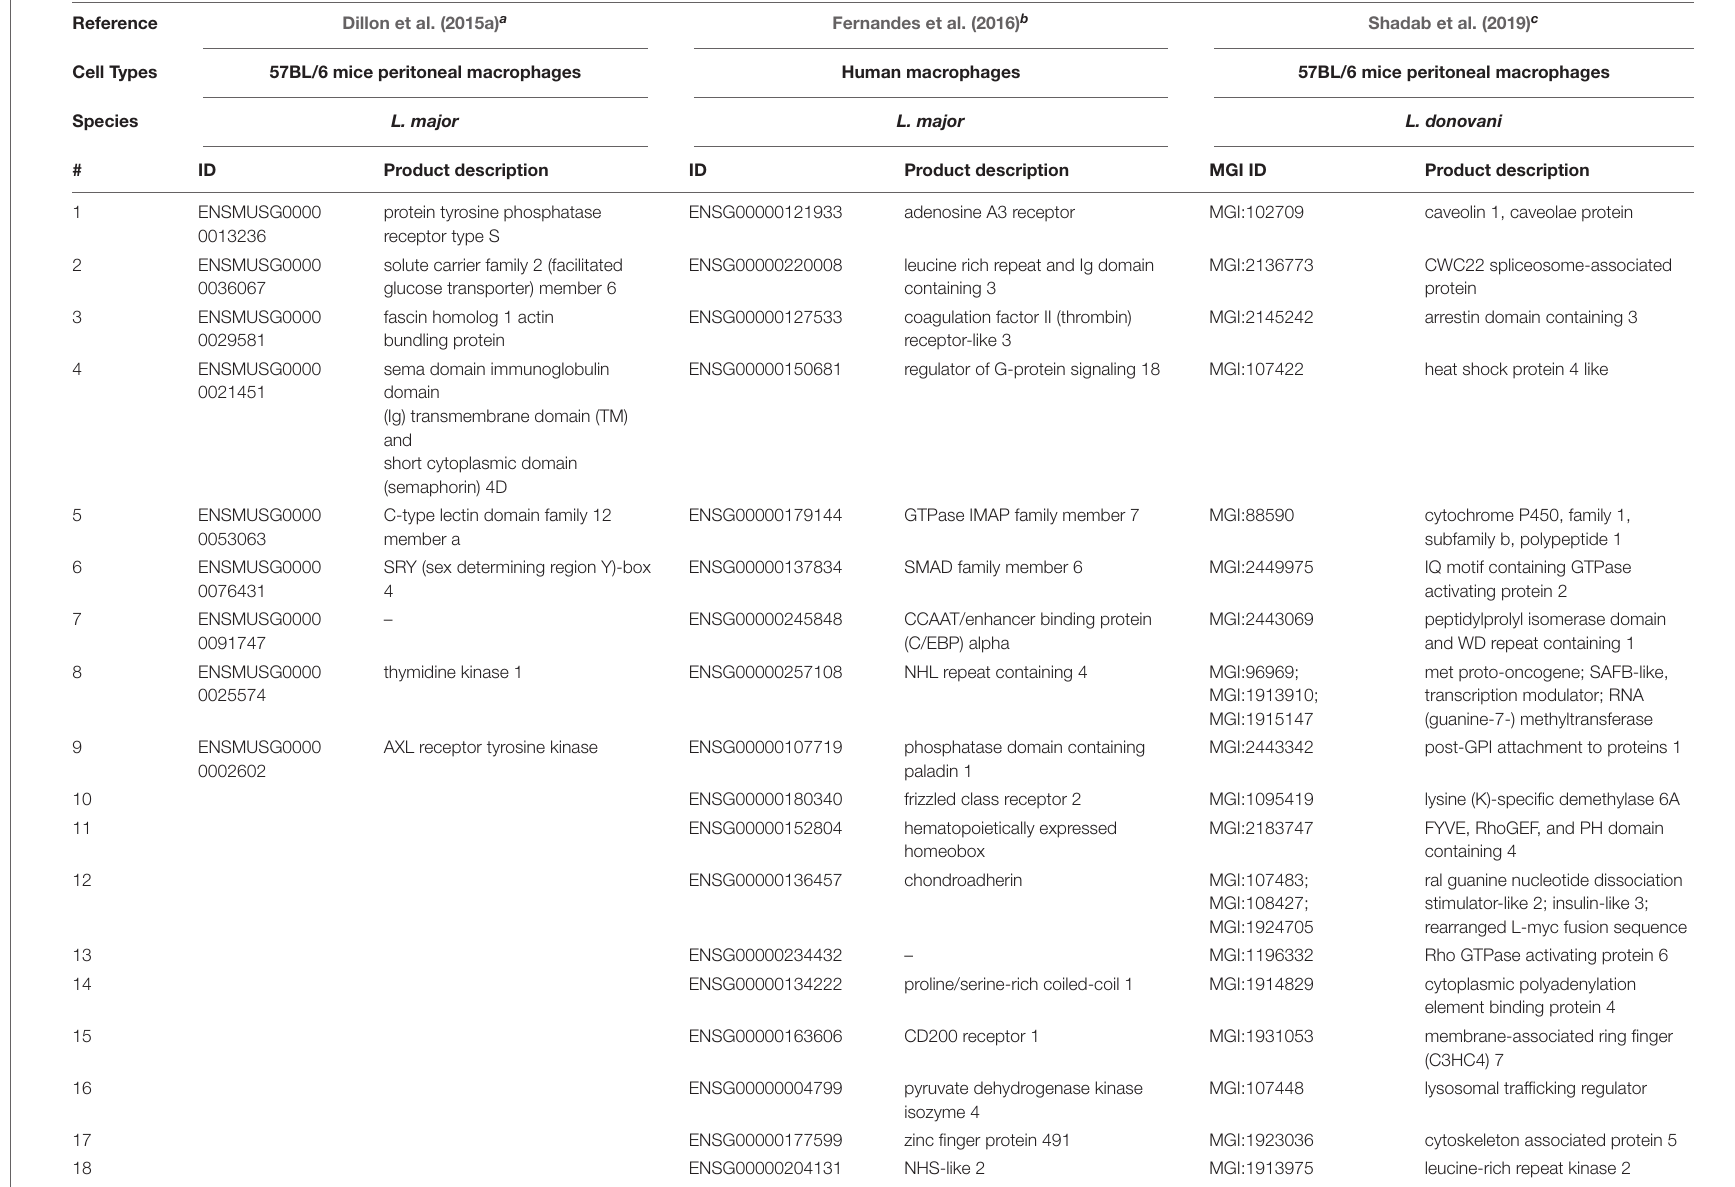
TABLE 4 | Top twenty down-regulated genes in macrophages following infection with various Leishmania species.